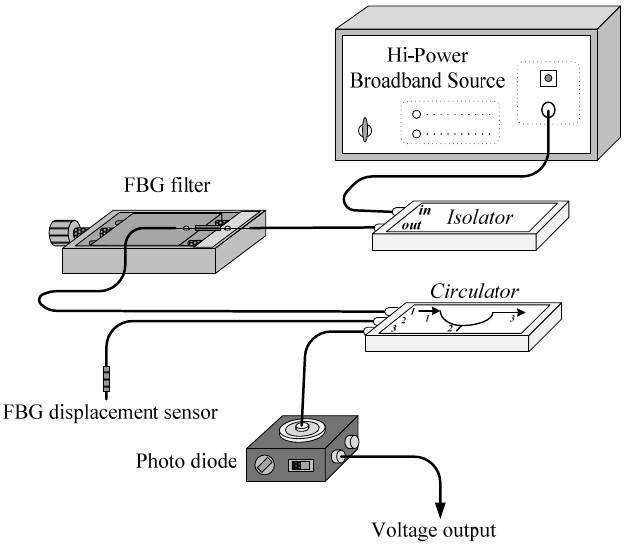
Figure 3. Schematic diagram for the FBG displacement sensing system.